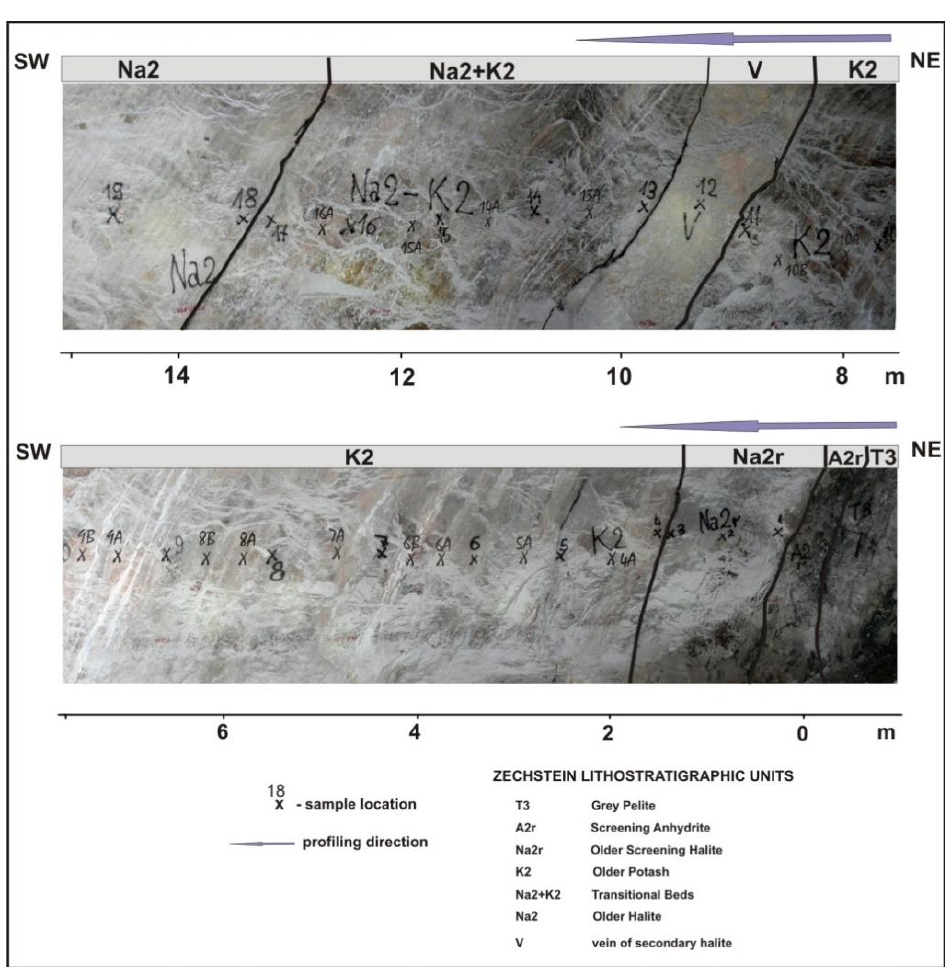
Figure 3. Sampled profile Z-2/1 of Na2+K2 and K2 lithostratigraphic units in the gallery of salt mine KŁODAWA S.A., mine level 600 m, Kłodawa salt dome.